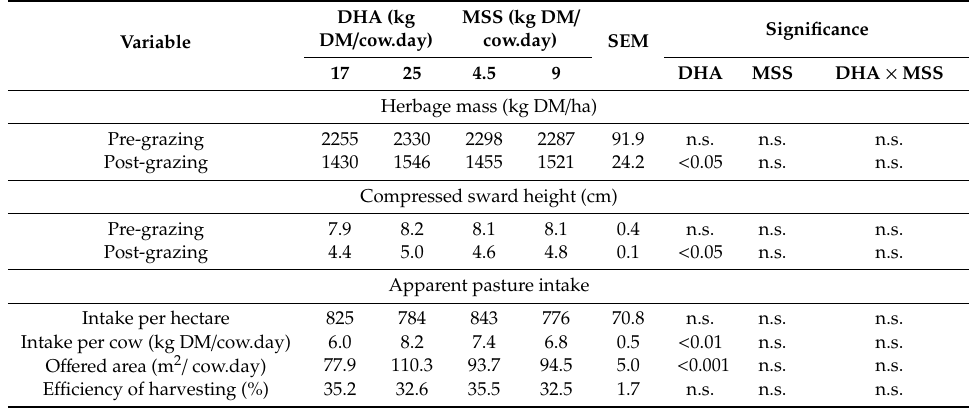
Table 1. Effects of daily herbage allowances (DHA) and maize silage supplementation (MSS) level on pre-grazing and post-grazing herbage mass, pre-grazing and post-grazing compressed sward height,